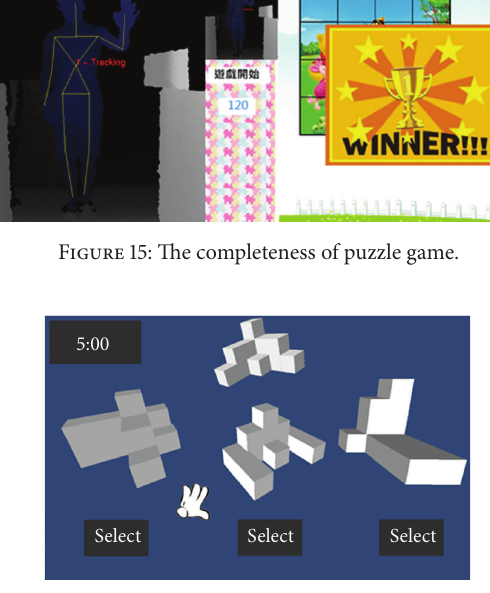
Figure 16: The illustration of geometric